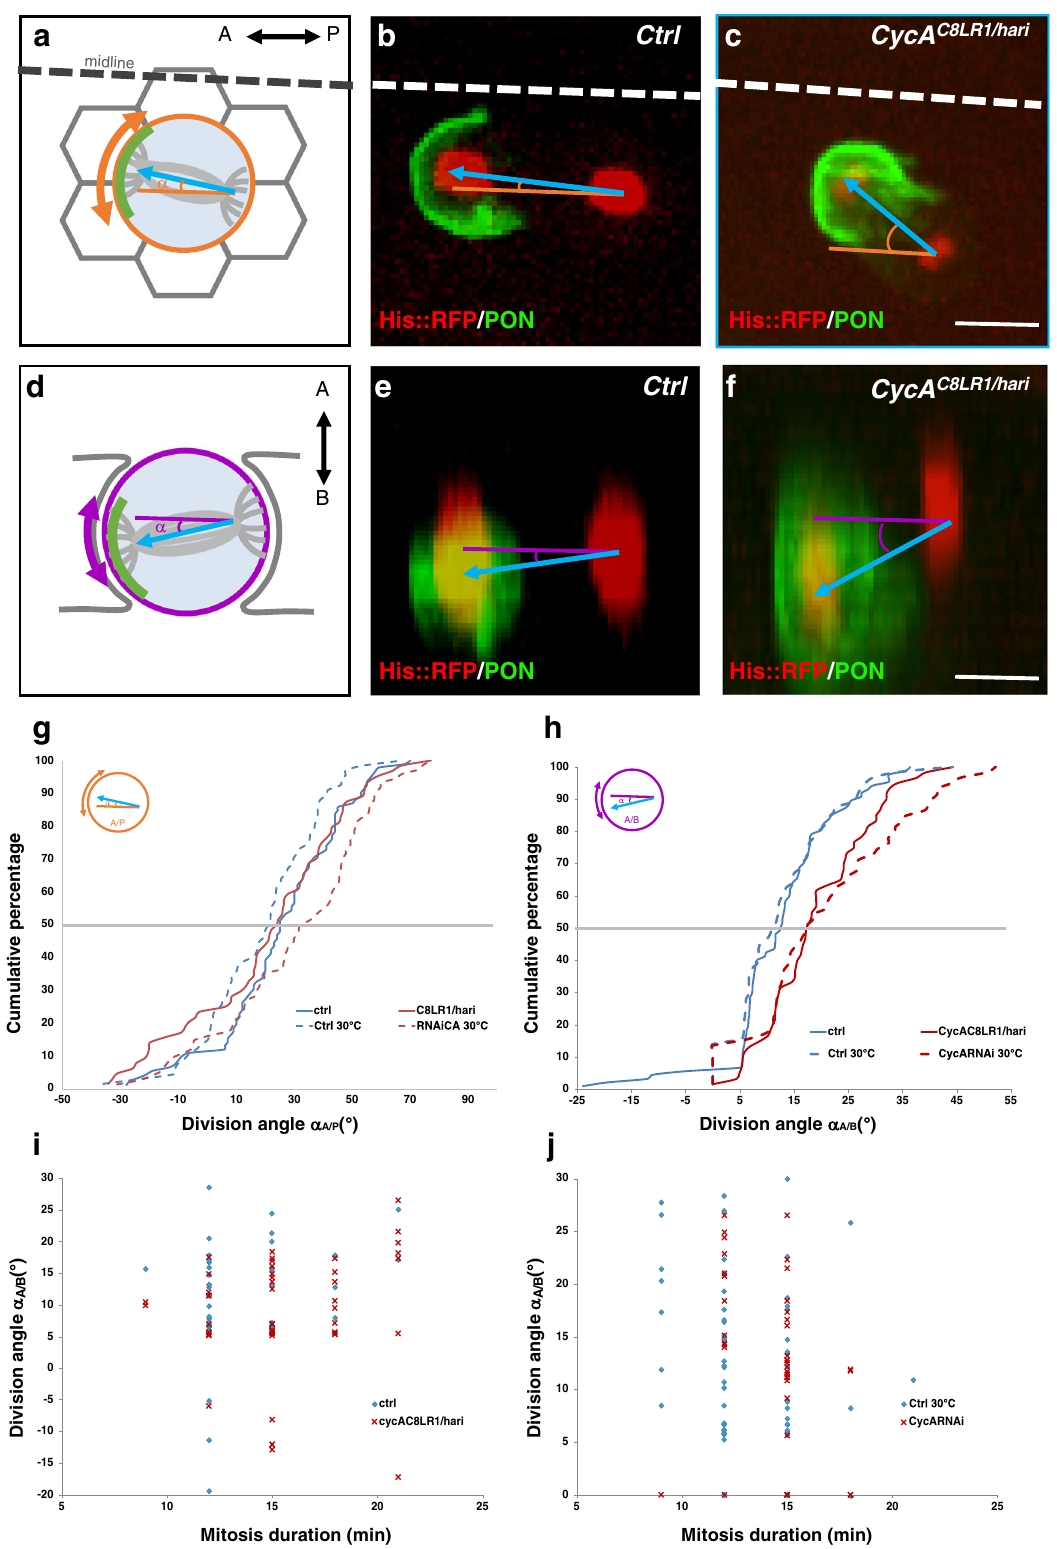
p = 0.0006) (Fig. 5f). Spindle orientation was also affected along the apico-basal axis, since the orientation of pI division was more orthogonally to the epithelial plane (18.1 ± 1.4 in PON-CA; CycA C8LR1/ + ( n = 52) compared to of 11.1 ± 1.3 in PON-CA ( n = 70) ( p = 0.0013) (Fig. 5g). Here again, misoriented divisions did not result from defects in mitotic progression